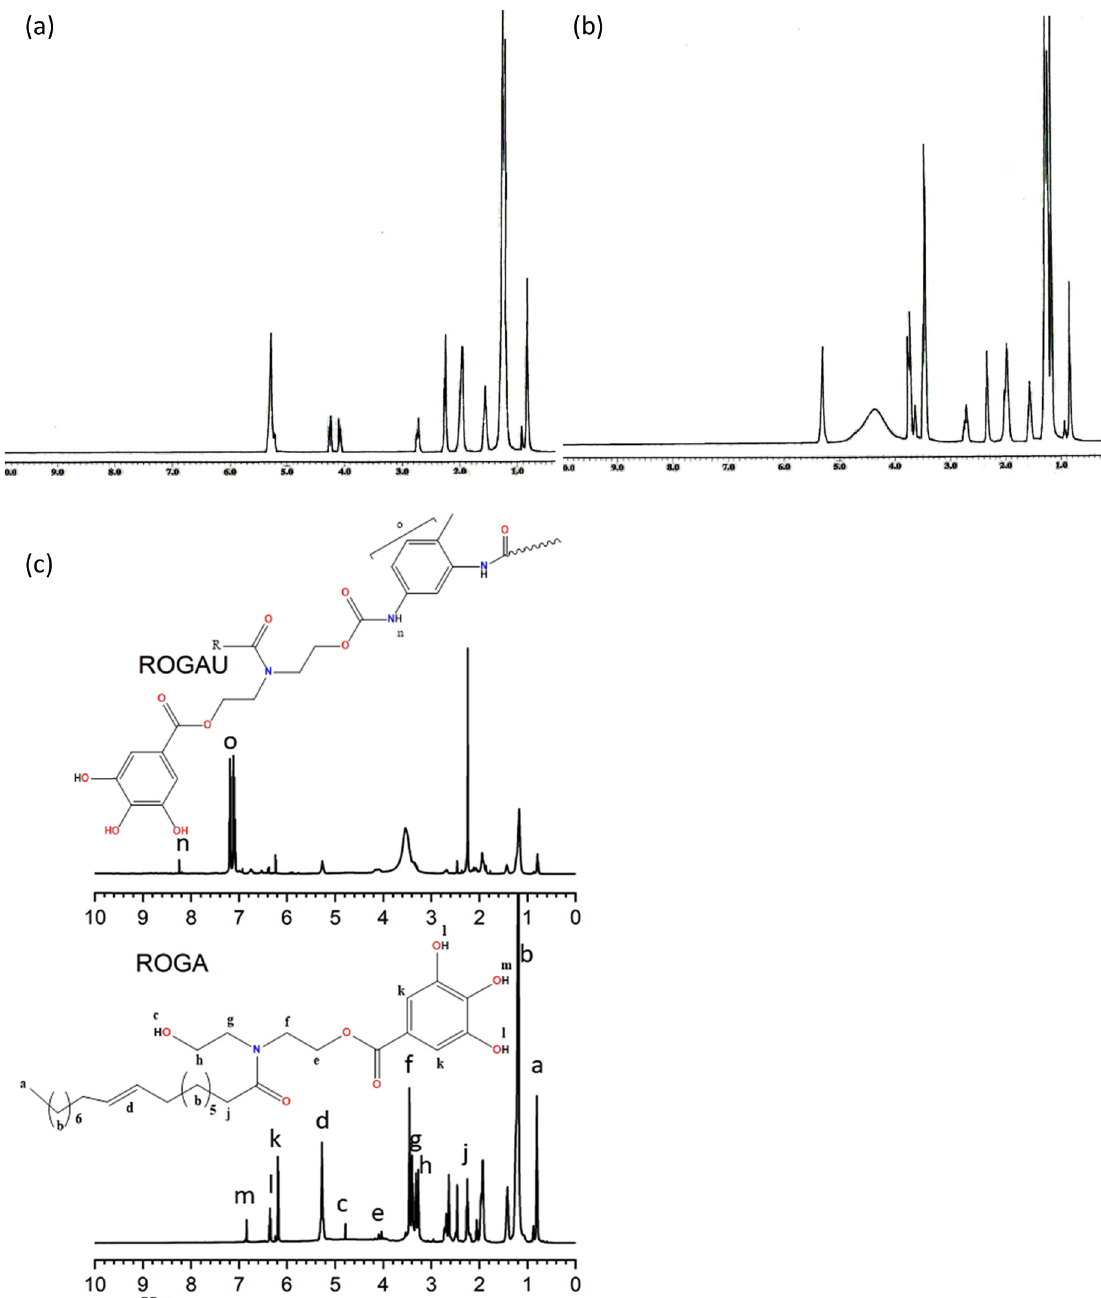
Figure 2: 1 H NMR spectra of ( a ) RO ( b ) HERA, ( c ) ROGA and